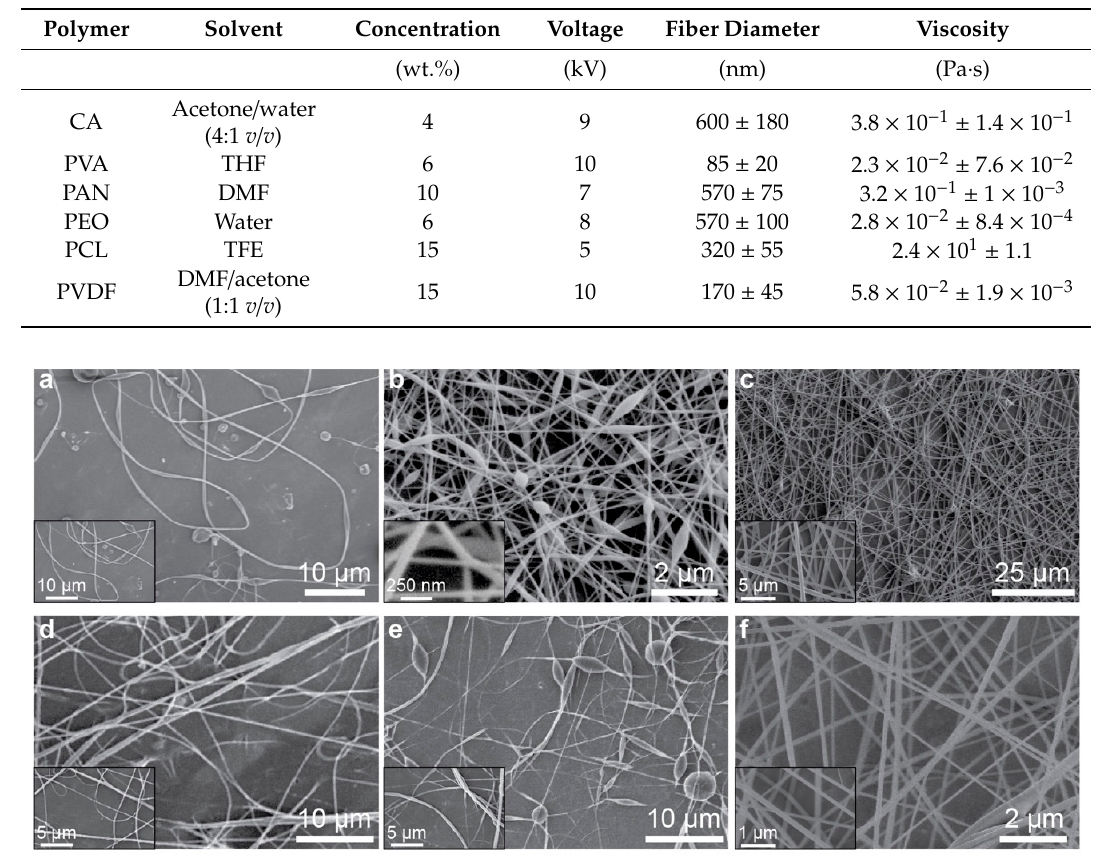
Figure 2. An array of nanofibers synthesized with the portable electrospinner: ( a ) 4 wt.% CA in acetone / water, ( b ) 6 wt.% PVA in THF, ( c ) 10 wt.% PAN in DMF, ( d ) 6 wt.% PEO in water, ( e ) 15 wt.% PCL in TFE and ( f ) 15 wt.% PVDF in DMF / acetone. Insets show SEM images of higher magnification.